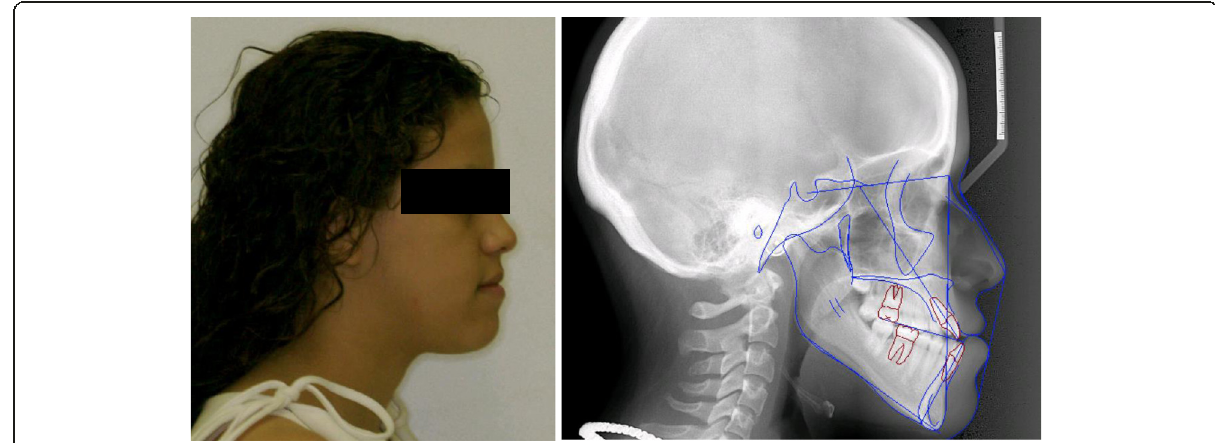
Fig. 1 Illustration of pre-treatment profile photograph and traced cephalometric radiograph of a subject included in the